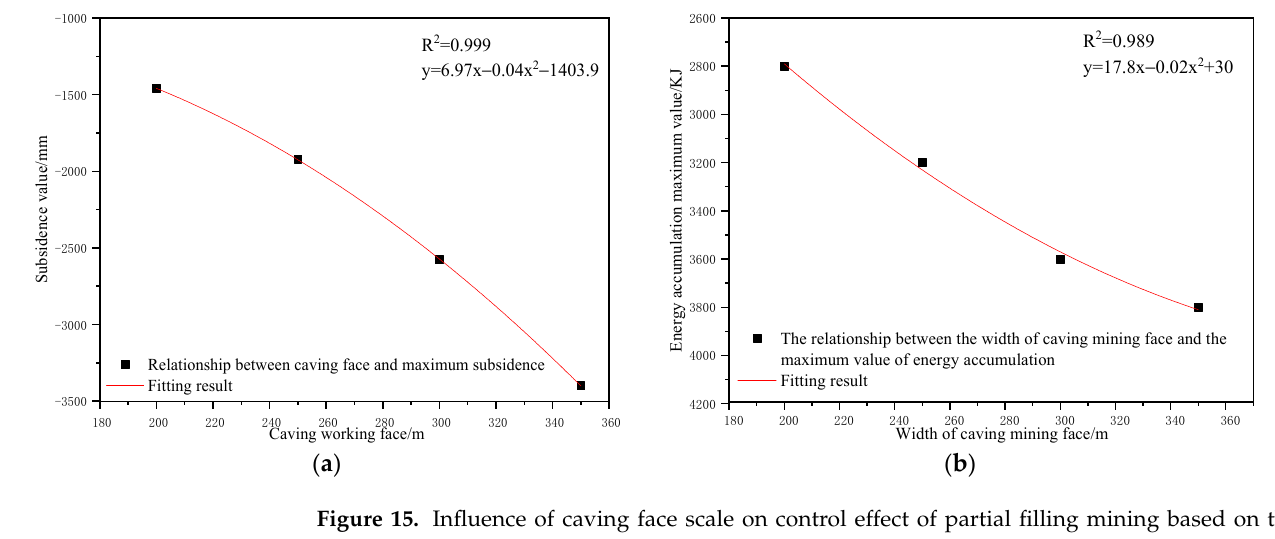
Figure 15. Influence of caving face scale on control effect of partial filling mining based on the main key stratum; ( a ) relationship between caving face scale and maximum surface subsidence. ( b ) Relationship between caving face scale and maximum energy polling distribution value.